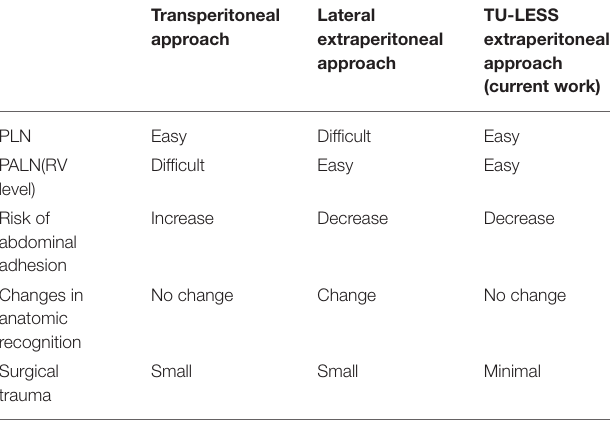
TABLE 3 | Advantages and limitations of three approaches for